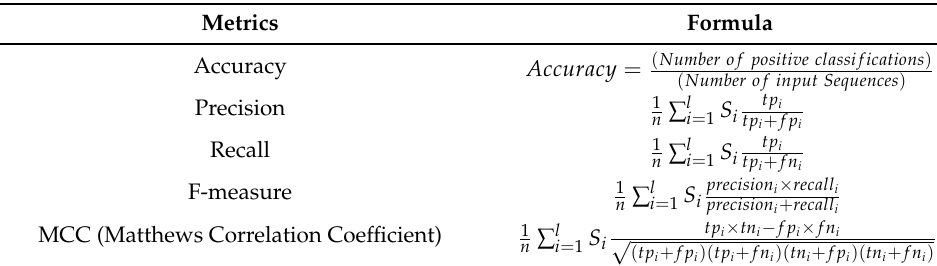
Table 2. Evaluation indicators of multi-class classification models.